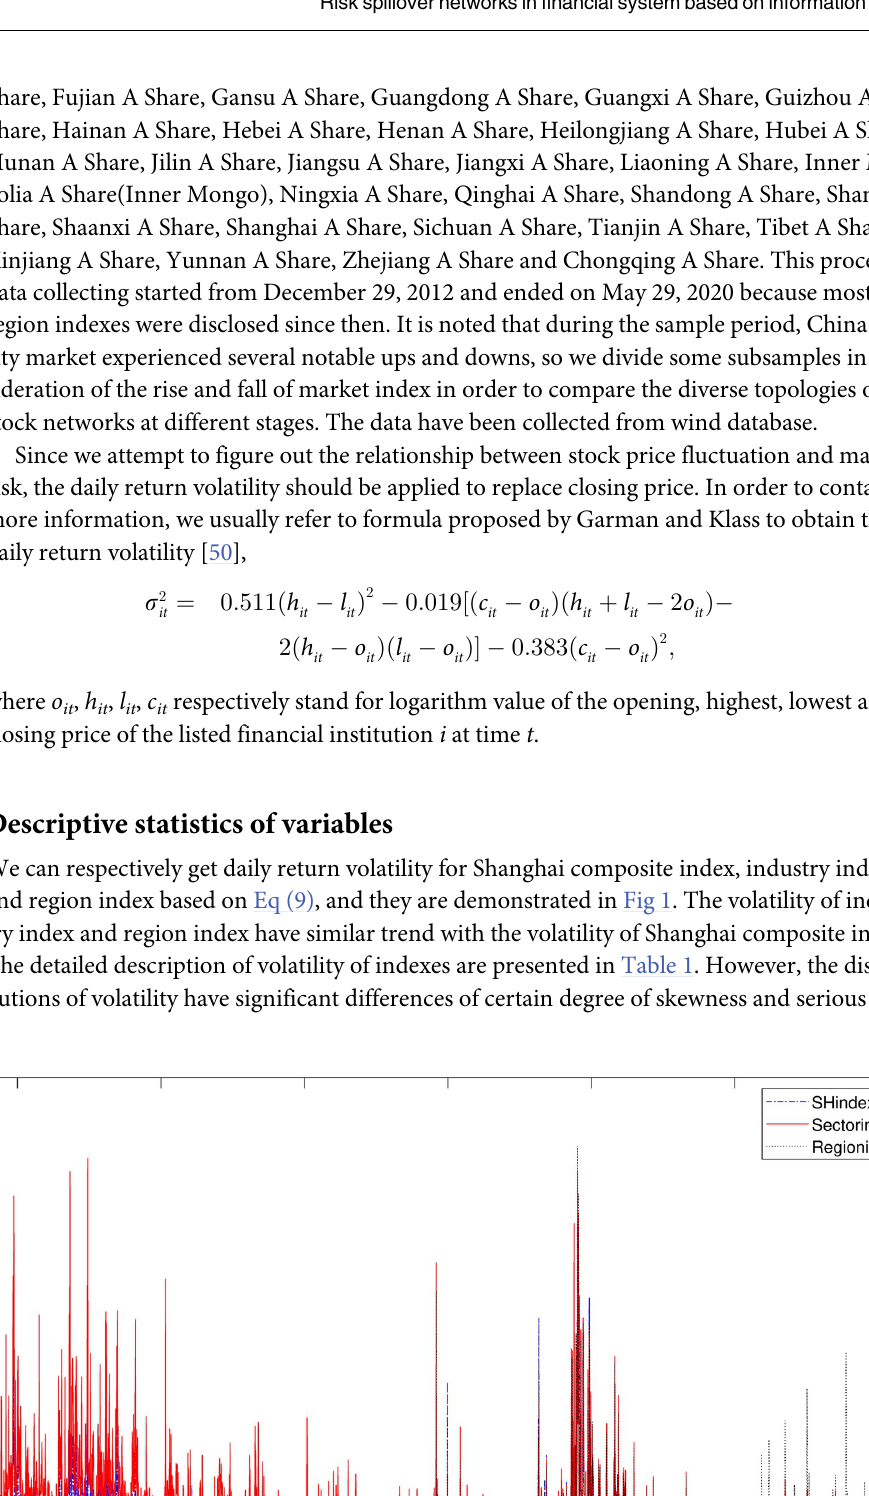
PLOS ONE | https://doi.org/10.1371/journal.pone.0252601 June 18,